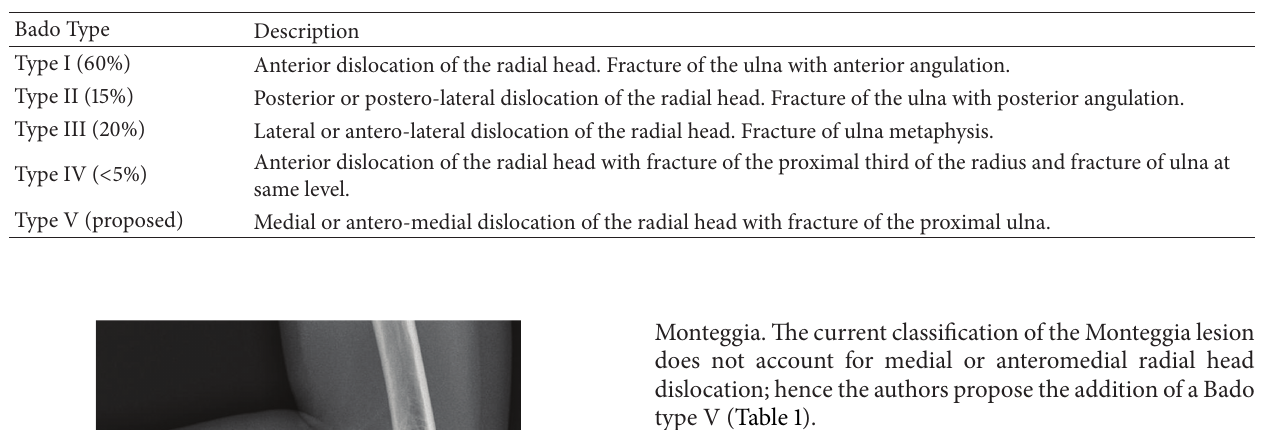
Table 1: Bado [1] classification of the Monteggia lesion with the proposed type V category.